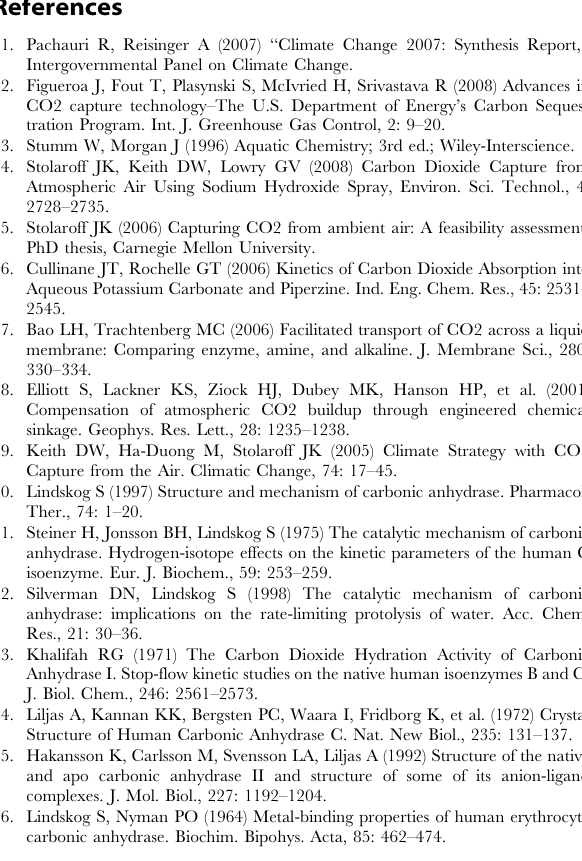
Table S1 Imaginary frequencies calculated for the gas-phase transition states of the individual catalysts. Values are in cm-1. The TS3*-axial structure was the transition state for axial release of bicarbonate from Ben . Table S2 Natural population analysis for the metal ion and coordinating oxygen within the calculated catalyst. The OH species is the isolated hydroxylated catalyst. Values with asterisk are for the coordinated water oxygen. All values are in |eu|. Text S1 Additional details on the experimental characterization and kinetics measurements of the zinc complex of tris(6-